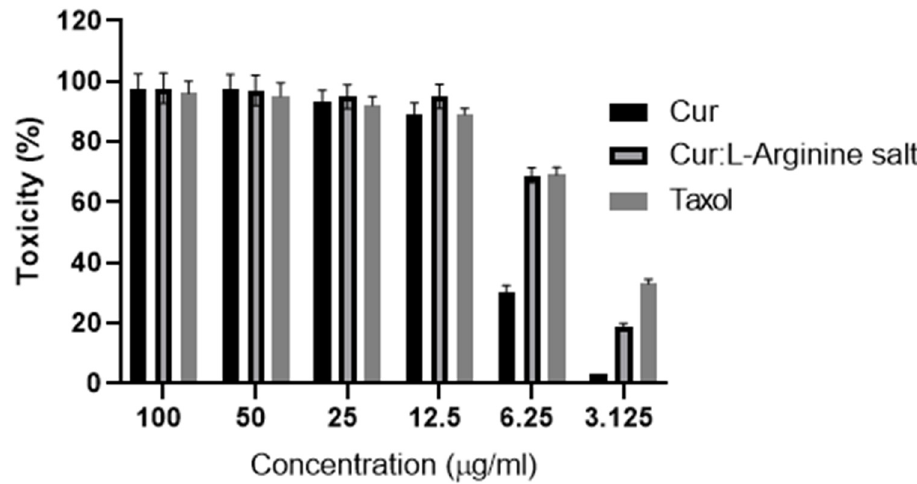
Figure 7. Cytotoxicity (%) of six different concentrations of curcumin, curcumin and L-arginine salt, and paclitaxel (Taxol ® ) using MCF-7 human breast epithelial cell lines (results are expressed as mean ± SD; n = 5).